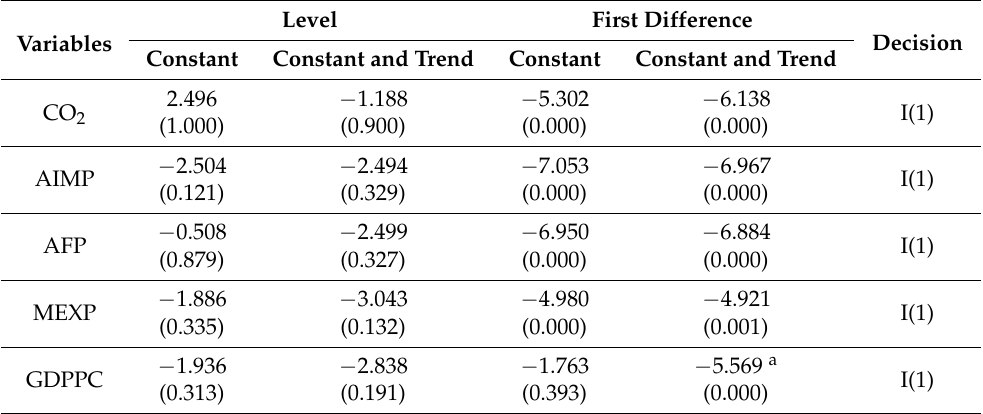
Table 3. ADF Unit Root